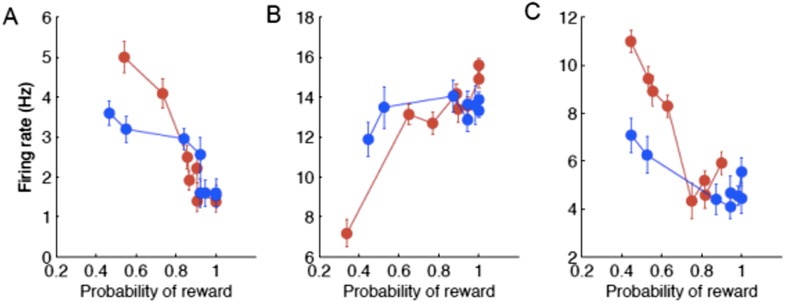
Examples of individual neurons with neuronal activity during the psacc (A,B) and reward ( C ) periods of the task as a function of the probability of reward sorted by the boundary position (red/blue correspond to slow/fast boundary positions).